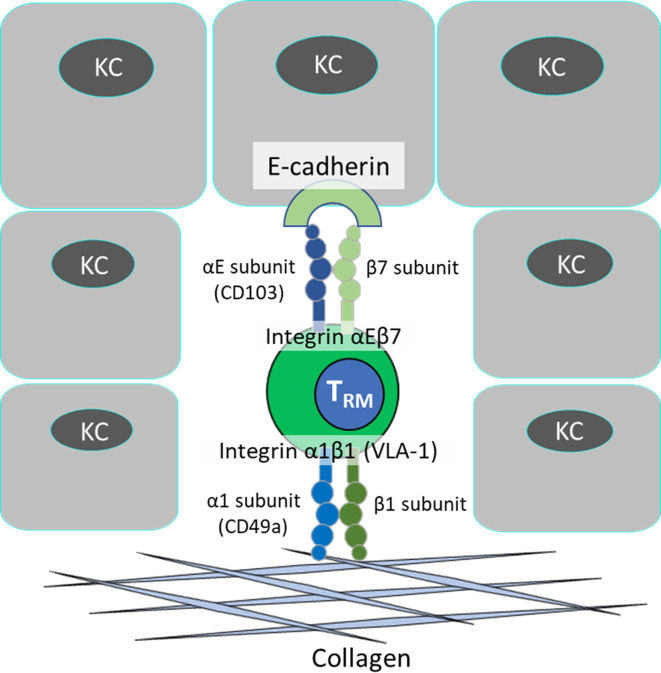
Adhesion of TRM cell in the skin.